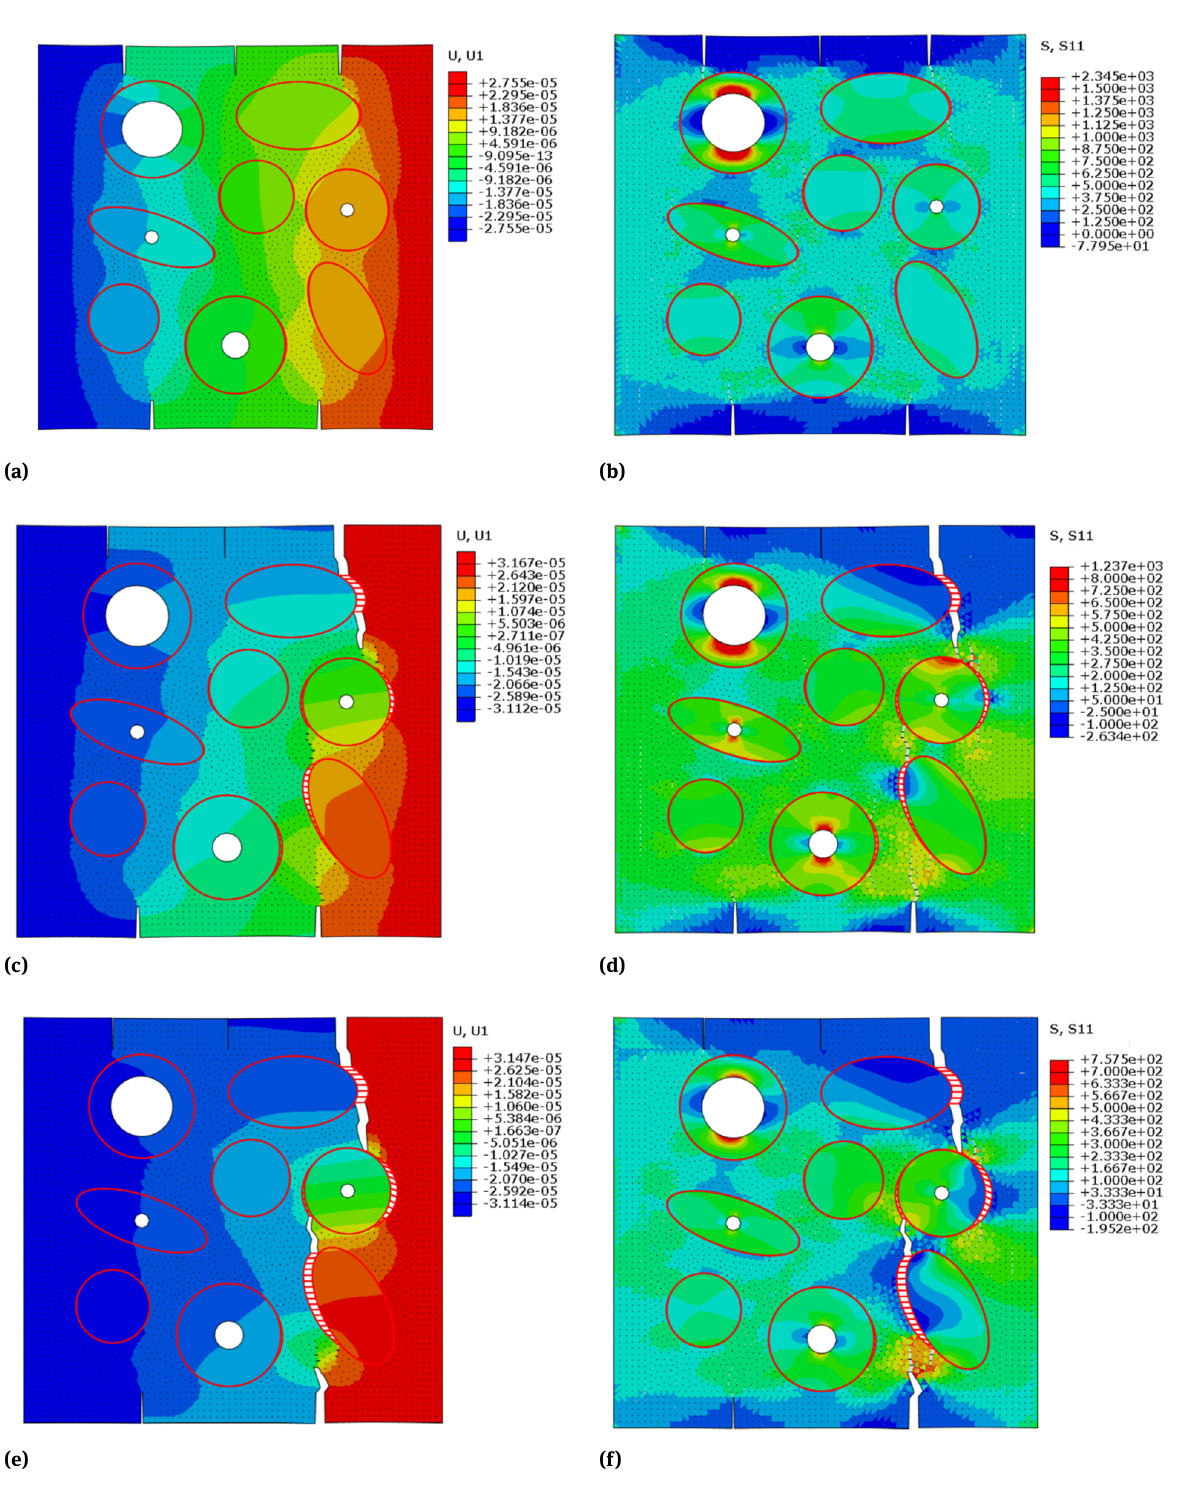
Figure 11: (a) (c) (e) displacement and (b) (d) (f) stress contour figures of the middle region of the cortical bone, in the cohesive FEM cracking simulation under uniform-speed displacement tension load along U1